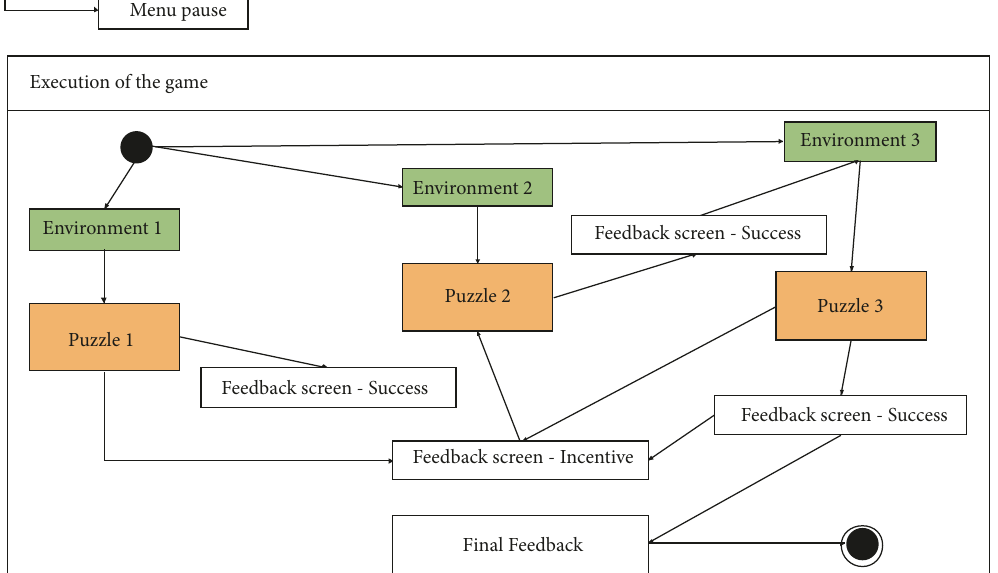
Figure 2: Activity diagram of ALTRIRAS